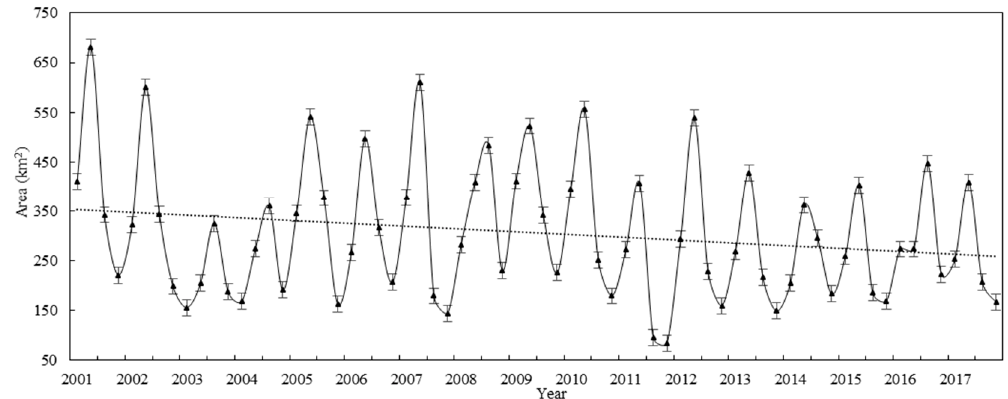
Figure 8. Average bloom areas in Dongting Lake in different seasons from 2001–2017.